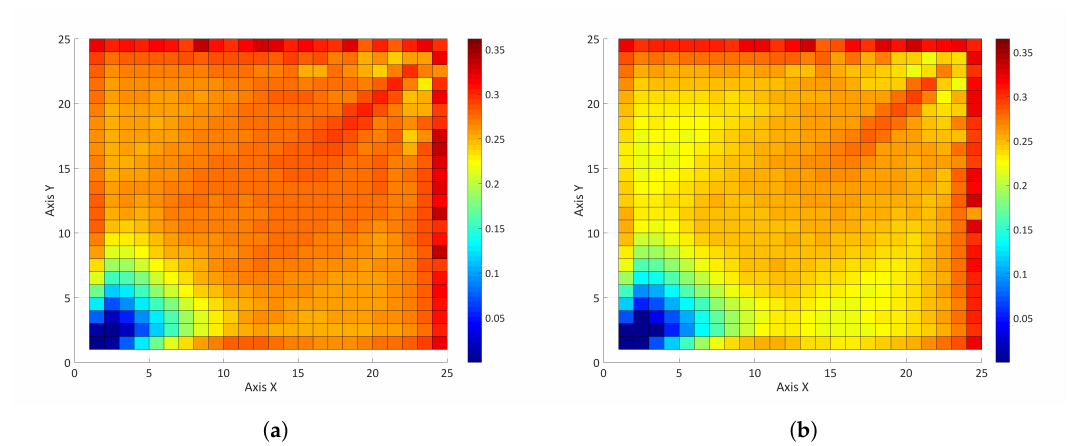
Figure 19. Oil saturation at the end of the EOR process considering an initial salt content of 0.5% ( a ) and 2.5% ( b ).